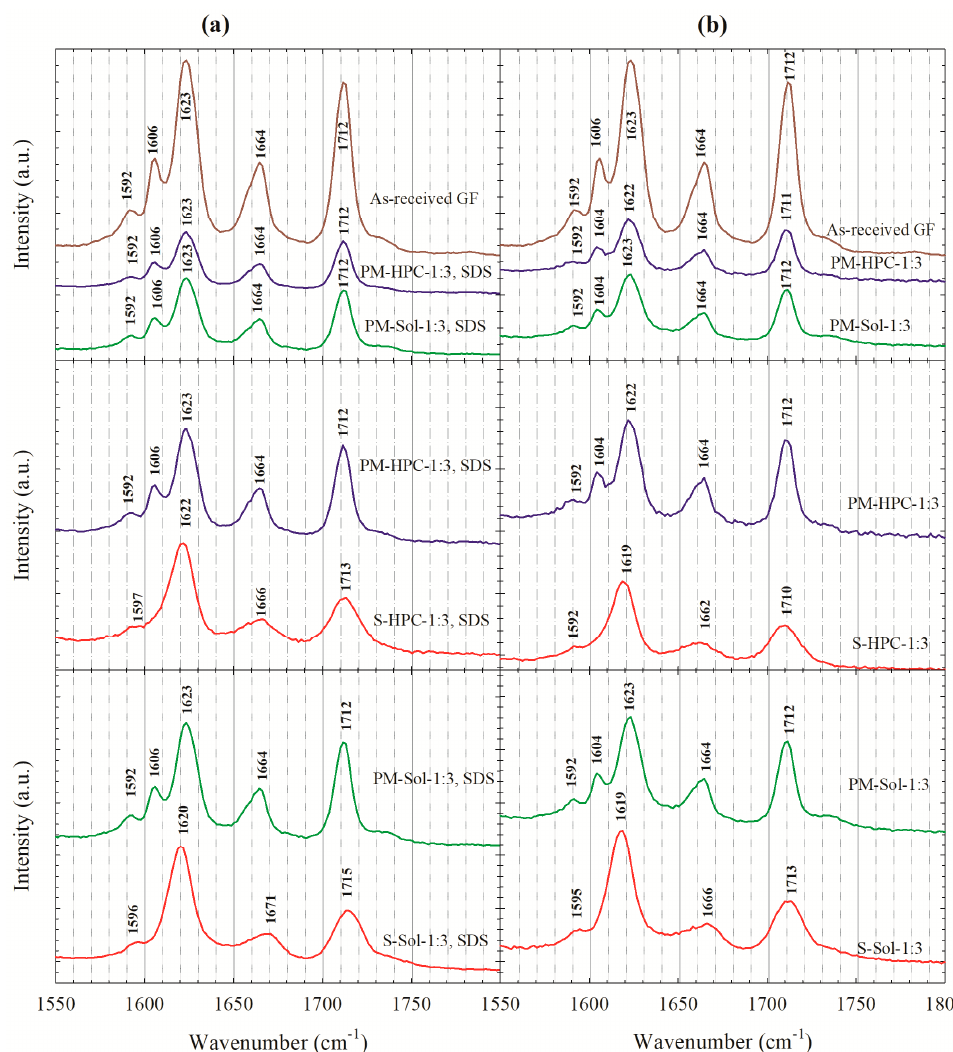
Figure4. Ramanspectraofas-receivedGF,physicalmixtures(PMs)ofGF–HPC / Solata1:3drug:polymer Figure 4. Raman spectra of as-received GF, physical mixtures (PMs) of GF–HPC/Sol at a 1:3 ratio, and the spray-dried powders prepared using the GF solution with a 1:3 GF:polymer mass ratio: drug:polymer ratio, and the spray-dried powders prepared using the GF solution with a 1:3 ( a ) with 0.125% SDS and ( b ) without GF:polymer mass ratio: ( a ) with 0.125% SDS and ( b ) without SDS.